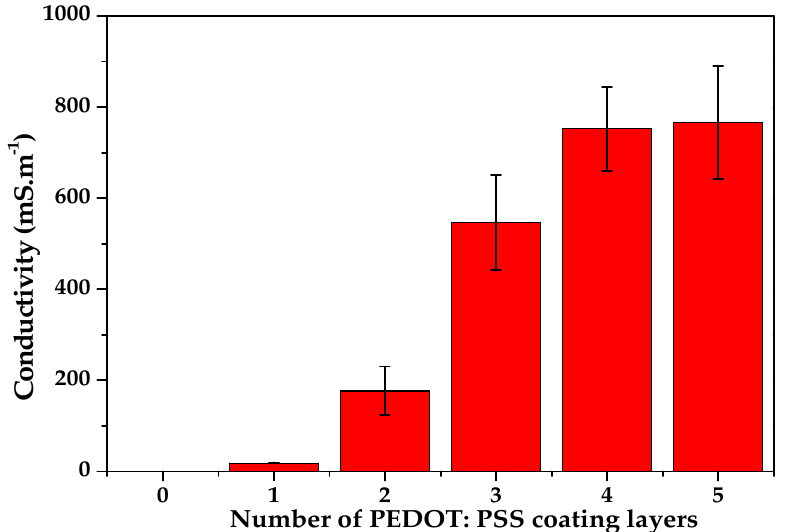
Figure 4. Electrical conductivity of the sensor yarn as a function of the PEDOT:PSS-coated layers.